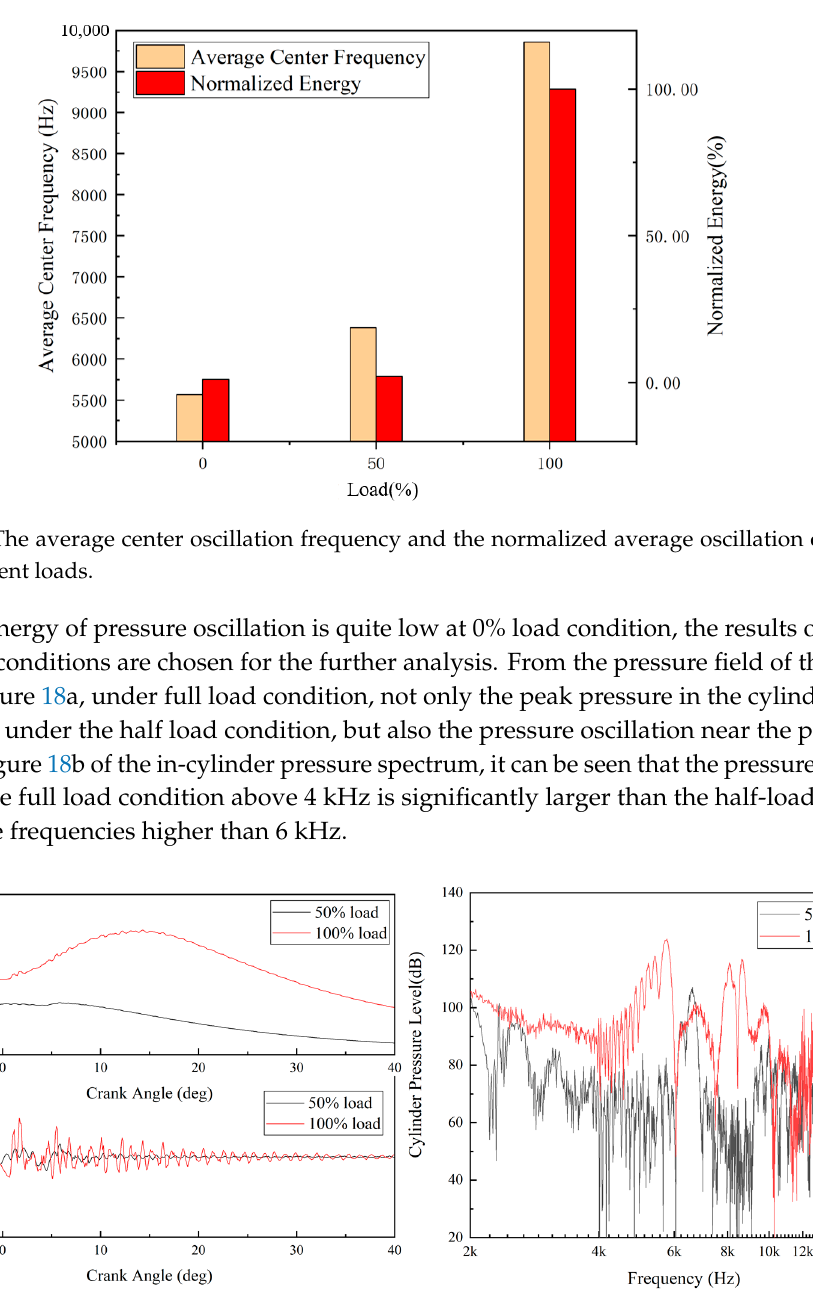
( b ) Figure 19. Time-frequency distribution (TFD) of different load: ( a ) 100% load; ( b ) 50% load. The detailed center frequency and normalized energy characteristics of in-cylinder pressure oscillation of the two loads are shown in Table 6. When the load increases the pressure oscillation energy will increase significantly, and center frequency of the dominant oscillation component will move from 6340 Hz of 50% load to 8800 Hz and 10,440 Hz of 100% load, an average center frequency will increase obviously. As the load change results shown in Figure 19 and Table 6, the frequency and energy characteristic of high-frequency oscillation are closely related to engine load. The increase in load brings more intense fluctuations of temperature and pressure. As a consequence, it is beneficial for the generation of high-frequency oscillation. Table 6. Average Center Frequency and Normalized Energy of 100% and 50% load.